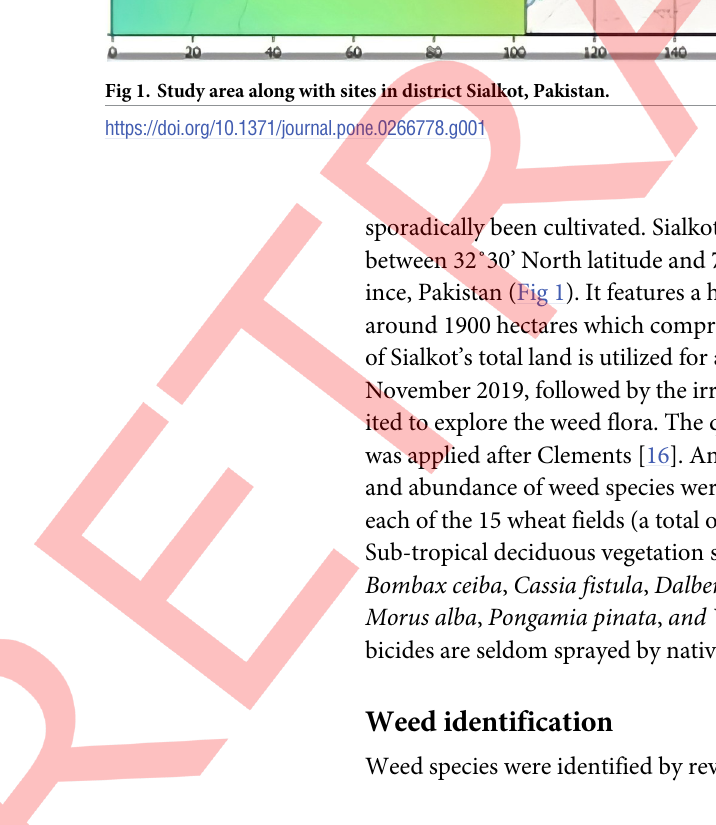
Fig 1. Study area along with sites in district Sialkot,